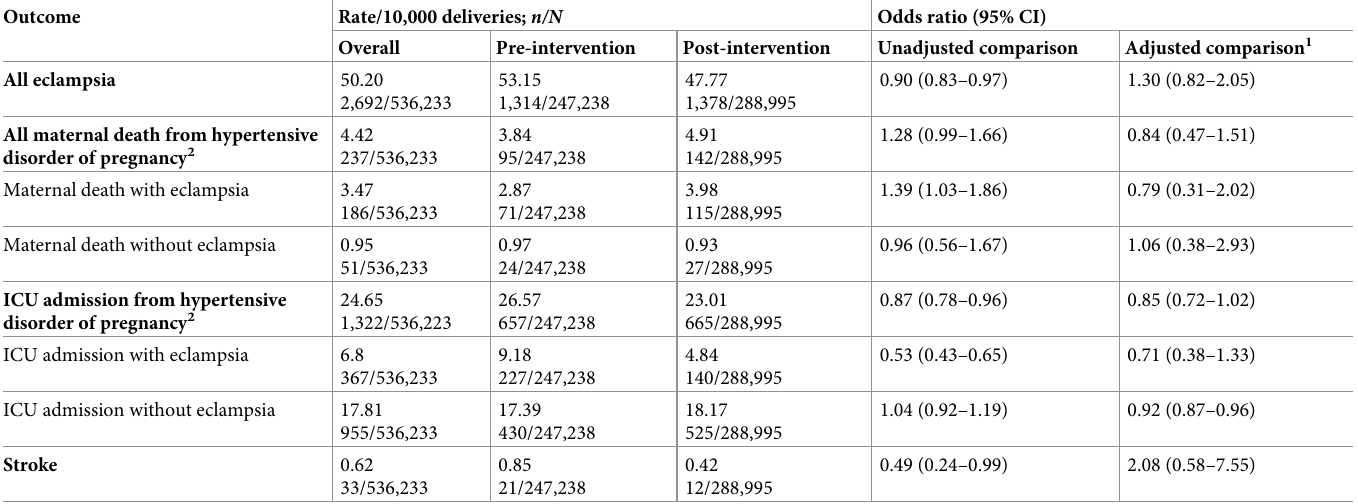
Table 1. Rates of eclampsia, stroke, and maternal death and intensive care unit admission as a result of hypertensive disorders of pregnancy, and effect of the CRA- DLE intervention on outcomes.